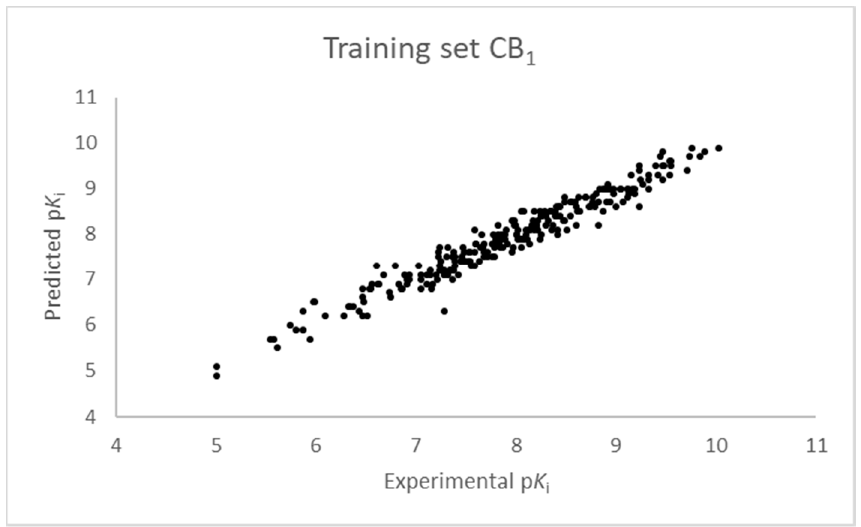
Figure 2. Ten component 3D-QSAR model experimental vs. predicted p K i of the compounds in the training set for the CB 1 receptor.